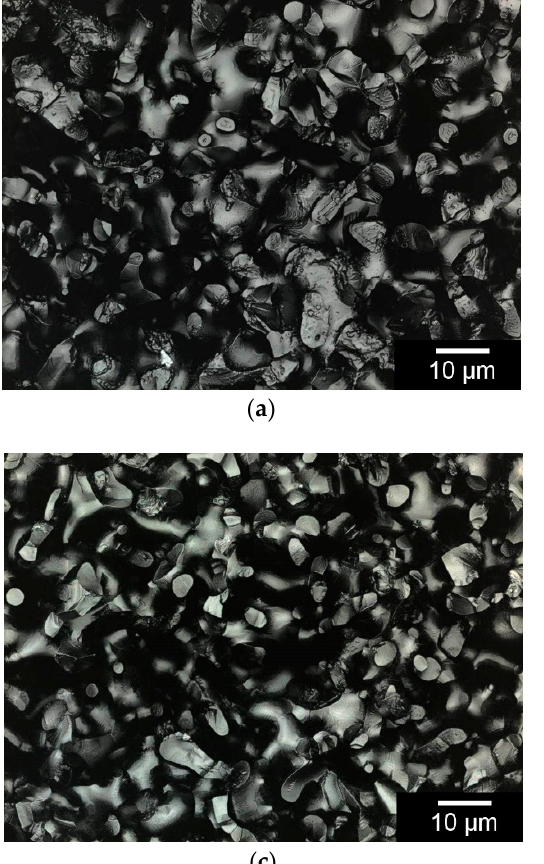
Table 5. Surface roughness of different samples .